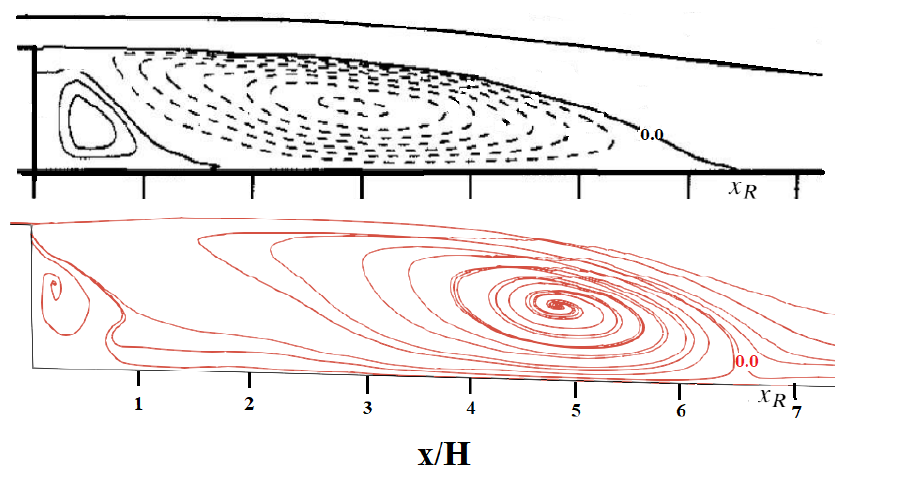
Figure 6. The distribution of the mean skin friction and Stanton number.